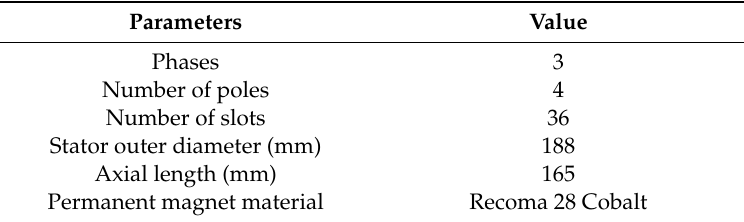
Table 3. Design parameters for